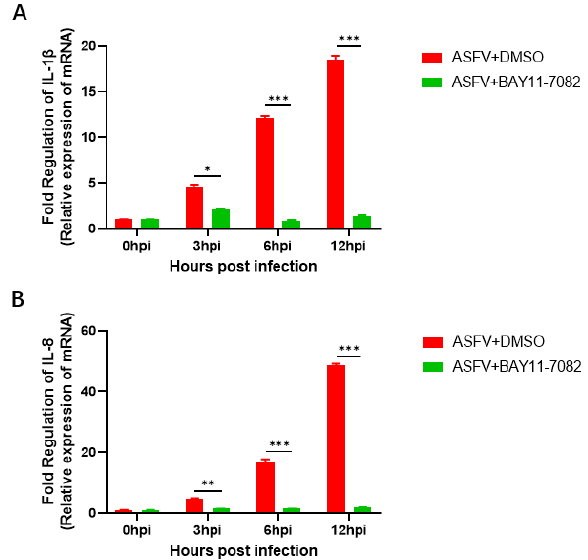
Figure 8. Changes in the expression of IL-1 β and IL-8 at the mRNA level. Real-time PCR was used to assess the expression of IL-1 β and IL-8 at the mRNA level in PAMs infected with ASFV, BAY11-7082 after 0, 3, 6 and 12 h. ( A ) Increased expression of IL-1 β was observed in ASFV in-fected cells, and this was reversed by BAY11-7082. ( B ) Increased expression of IL-8 was observed in ASFV infected cells, and this was reversed by BAY11-7082. Each datum represents results of three independent experiments (means ± SD). Significant differences compared with the control group are denoted by * ( p < 0.05), ** ( p < 0.01) and *** ( p < 0.001).